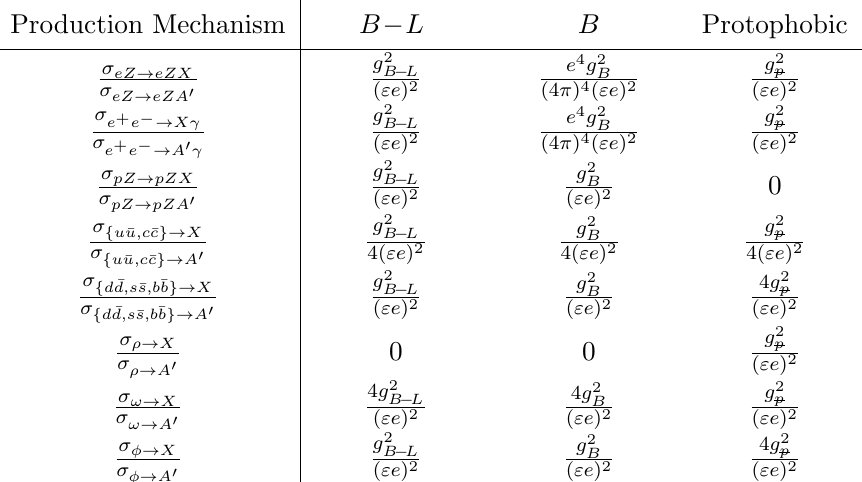
Table 2 . Production rates for the models in table 1 relative to those of the dark photon, except for meson-decay rates which are provided in table